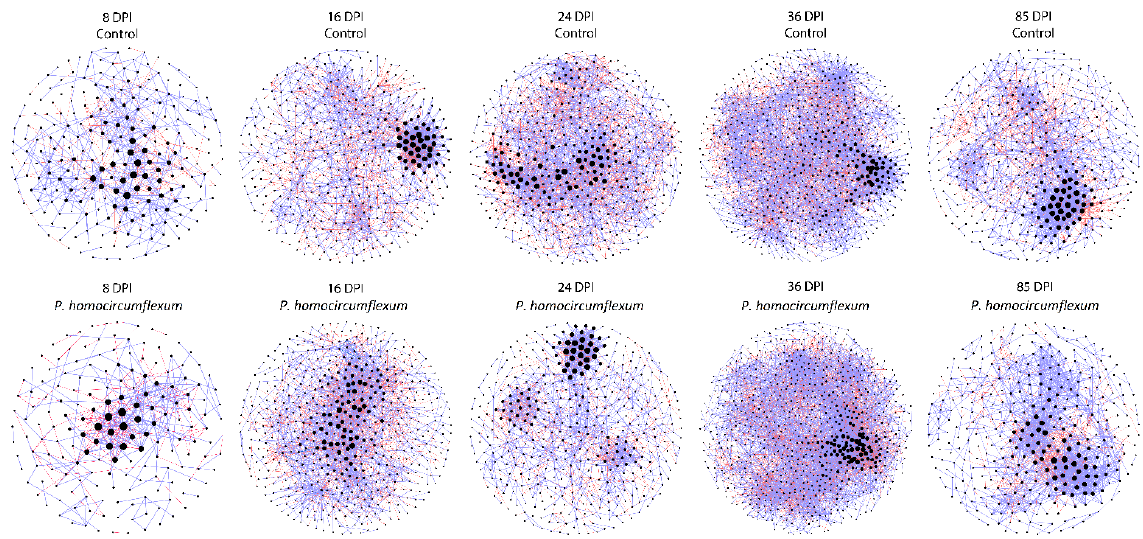
Figure 4. Co-occurrence networks of bird microbiome in the different experimental groups at 8, 16, 24, 36 and 85 DPI. Bacterial co-occurrence networks were inferred from the microbiome of P. homocircumflexum -infected birds and control. Nodes represent bacterial taxa and connecting edges stand for a co-occurrence correlation (SparCC > 0.75). Node sizes are proportional to the eigenvector centrality value. Edges representing positive or negative correlations were colored in lilac and red, respectively. Only nodes with at least one connection are displayed. Table 1. Topological parameters of co-occurrence networks.